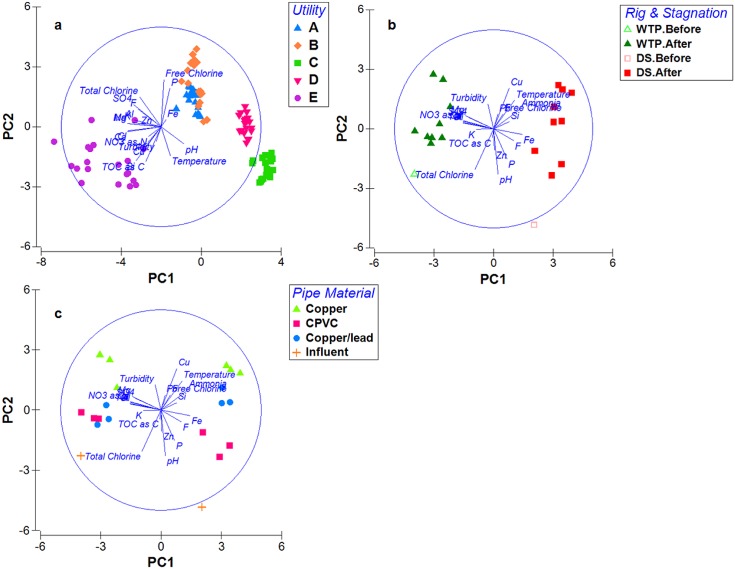
Dissimilarity in water chemistry of samples from different utilities, rig locations, and pipe materials.PCA plot of water chemistry data. Each point represents a water sample, with proximity of points in 2-D space indicative of relative similarities. Principle component (PC) 1 and PC2 are combinations of water chemistry variables that best explained variation among samples. a. samples from five utilities (n = 100 samples), color and shape coded based on utility location; PC1 and PC2 explained 44.2% and 27.3% variation, respectively. b. samples from Utility E (n = 20), shape coded by rig location and color coded by stagnation stage; PC1 and PC2 explained 46.5% and 16.3% each. c. samples from Utility E, color and shape coded by pipe material; PC1 and PC2 explained 46.5% and 16.3% each.